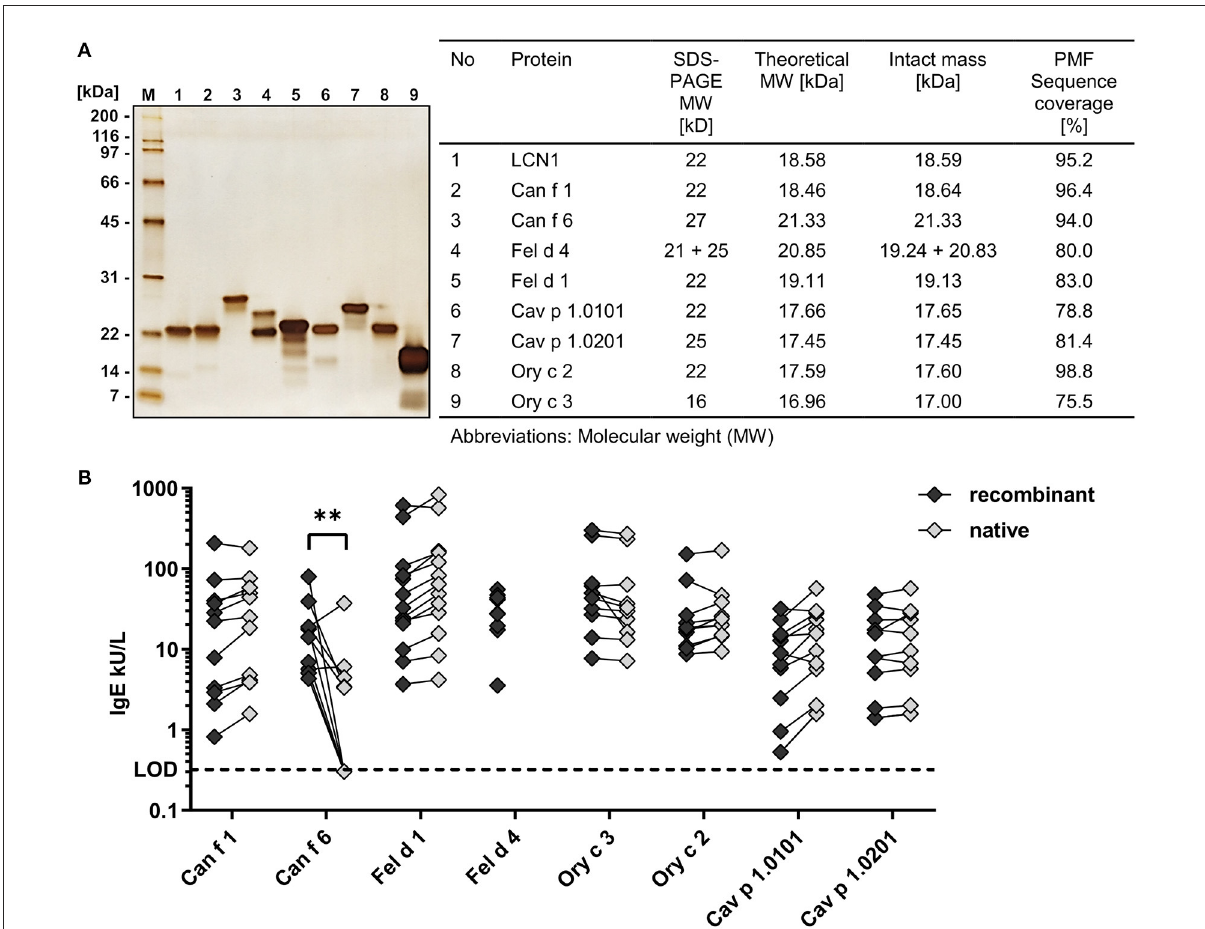
FIGURE1 Recombinant allergens are of high purity and show a comparable IgE-binding to their native counterpart. (A) SDS-PAGE and silver stain of eight purified recombinant mammalian respiratory allergens and the human homolog LCN1 (200 ng protein per well). Intact masses and amino acid sequence identity of recombinant allergens and LCN1 were analyzed by mass spectrometry. (B) Comparison of specific IgE-binding of allergic patient sera to recombinant allergens and their native counterpart by ELISA ( n = 9–13 patients). Median IgE-reactivity was compared between the recombinant and the native form by Multiple Mann-Whitney test ( ** P -value = 0.0028). Statistical analysis using Wilcoxon matched-pairs signed rank test between recombinant and native allergens resulted in no discoveries [FDR (Q) = 1%]. No native Fel d 4 was available. Lower limit of detection (LOD) ≤ 0.32